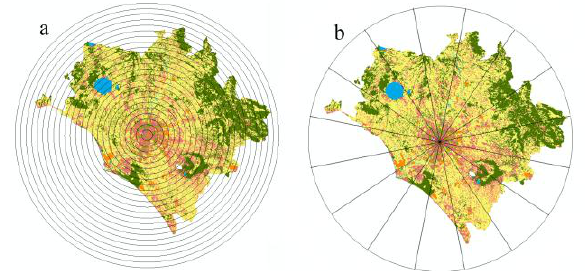
Figure 4. (a) Concentric zones and (b) sectors defined in the study area, superposed on the 2006 LULC map